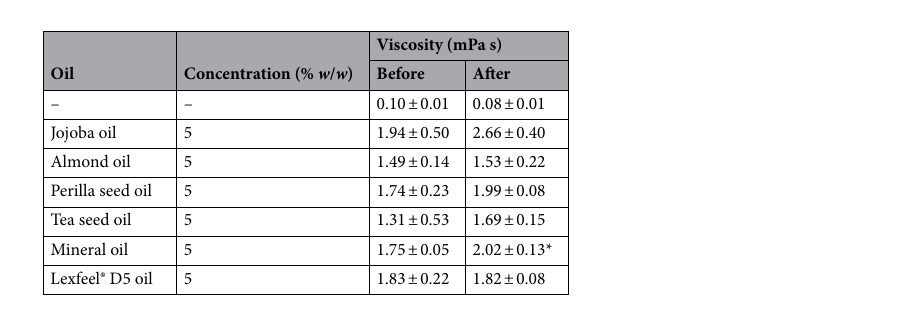
Table 4. Viscosity of lamellar liquid crystals (LLCs) using various oil types before and after eight heating– cooling cycles to test stability. Asterisks (*) denote a significant difference in viscosity before and after the heating–cooling stability test (* p <